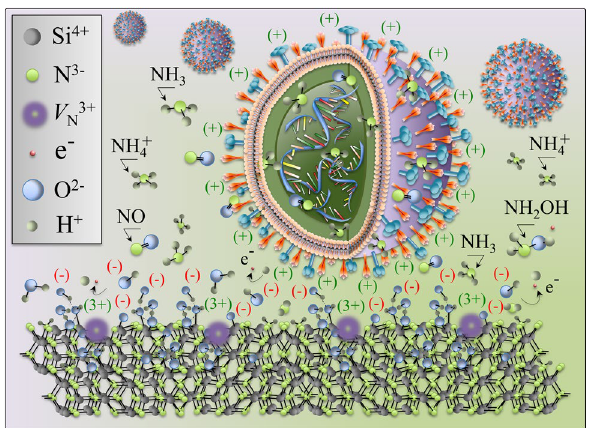
Figure 11. Schematic draft of the dual effect of “catch-and-kill” viral inactivation at the interface between Influenza A virions and Si 3 N 4 : negatively charged silanol groups attract the virions at the HA methionine terminus, while highly volatile NH 3 (eluted by the Si 3 N 4 surface) and NO (formed by reactions with ROS from split water) molecules penetrate the virions and damage their RNA sequence by alkaline transesterification and uracil/guanine ring